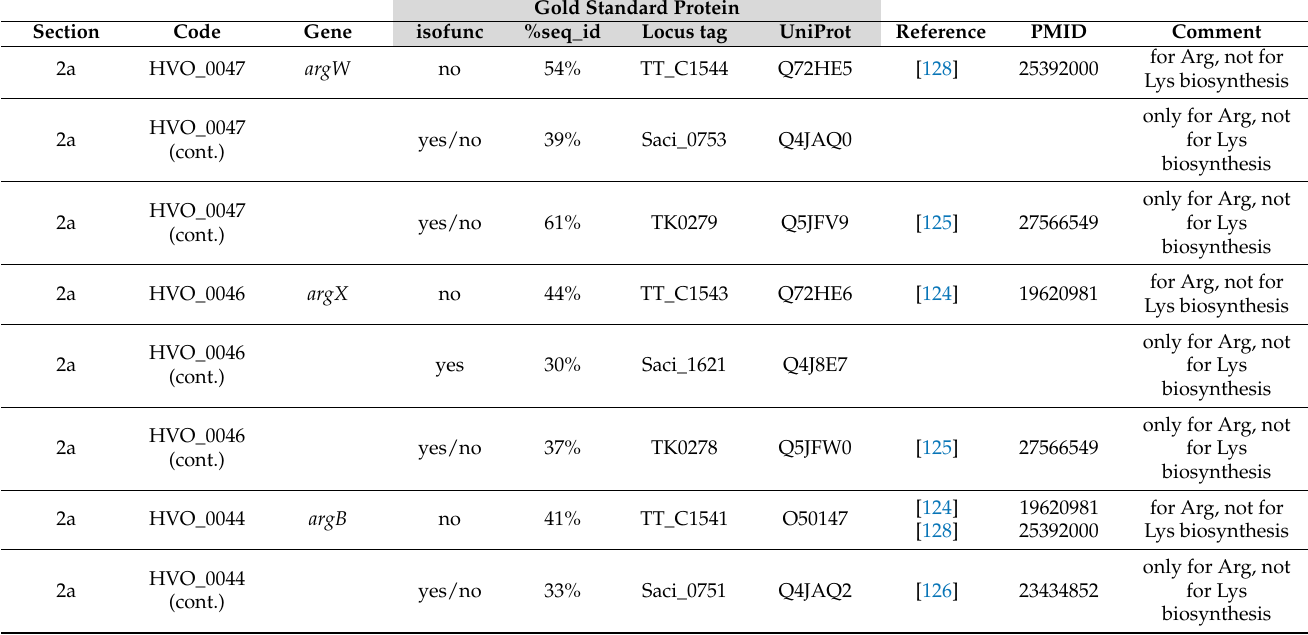
Table 2. Proteins with open annotation issues and their Gold Standard Protein homologs (Section 3.2). For a description of this table, see the legend to Table